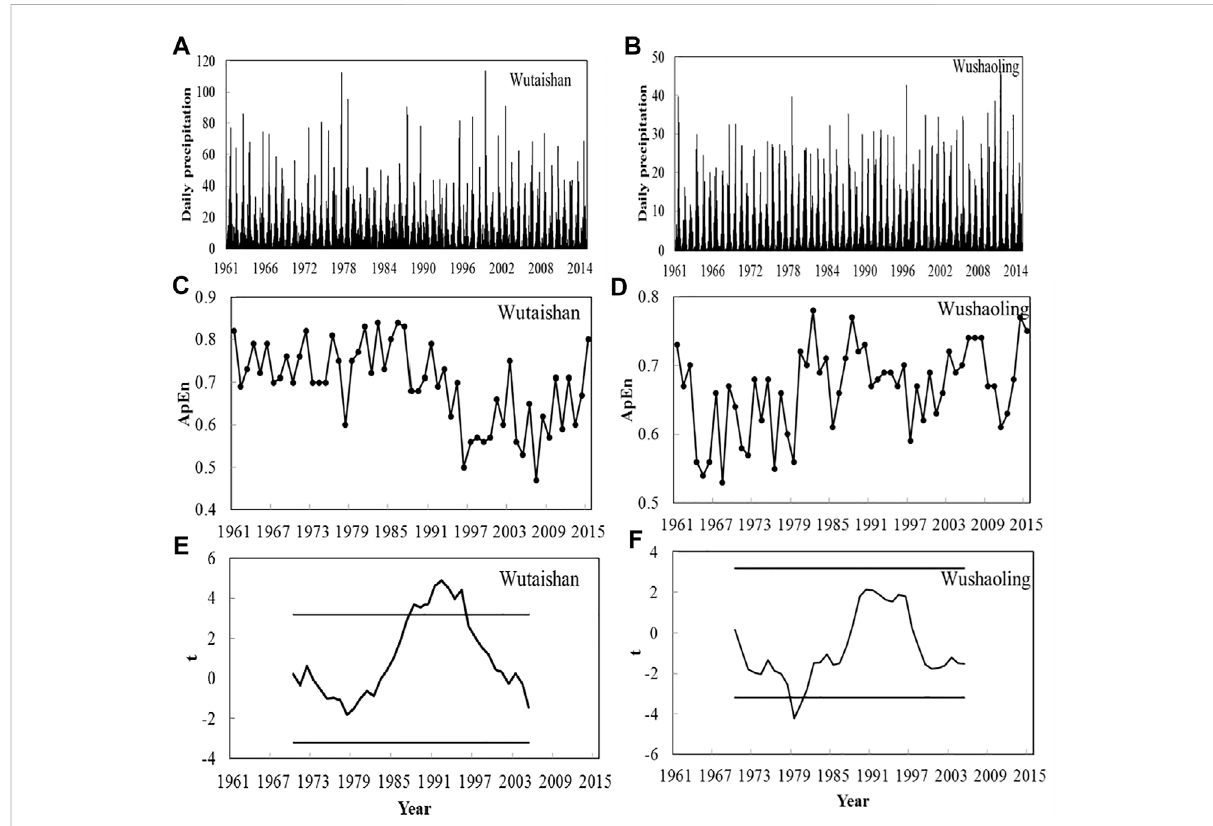
FIGURE 7 Daily precipitation series from 1961 to 2015 from the Wutaishan station in Shanxi Province and Wushaoling station in Gansu Province, and the ApEn results and the corresponding MTT results are shown. Daily precipitation records at the Wutaishan station (A) and at the Wushaoling station / (B) ; (C) ApEn results for the precipitation records shown in (A) ; (D) same as (C) , but for the precipitation records shown in (B) ; (E) MTT analysis of the ApEn results shown in (C) with the subseries n 1 = n 2 = 10; (F) same as (E) , but for the ApEn results shown in (D) .